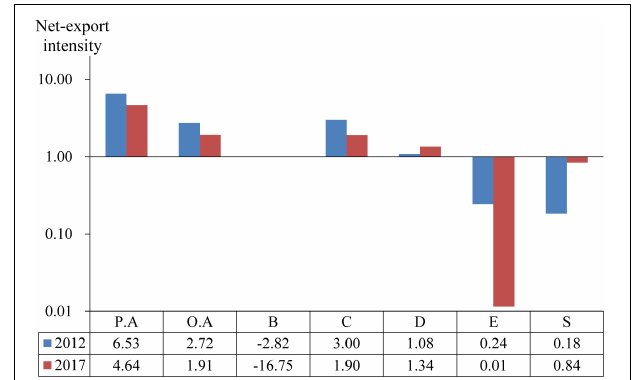
FIGURE 5 | Net export intensity of virtual water of different sectors in Zhangye in 2012 and 2017. Positive value represents net exports, while negative value represents net